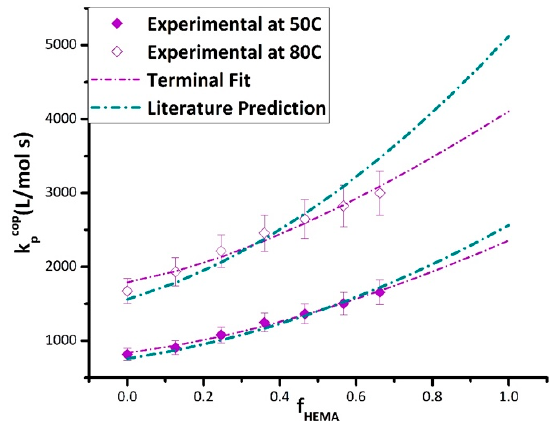
Figure 6. Comparison of k p,cop HEMA/BMA experimental data measured by PLP-SEC experiments at 50 (solid symbols) and 80 °C (open symbols) to terminal model predictions using literature k p,BMA and k p,HEMA values (blue lines), and with best-fit k p,BMA and k p,HEMA values from parameter estimation (purple lines) as summarized in Table 3. Data are shown with 10% error bars. Table 3. A comparison of BMA and HEMA homopolymerization k p (L/mol s) values in bulk taken from literature [5,10], experimentally determined in this study (BMA only), and estimated (with 95% confidence intervals) according to the terminal model (Equation (5)) with r HEMA = 2.27 and r BMA = 0.66.